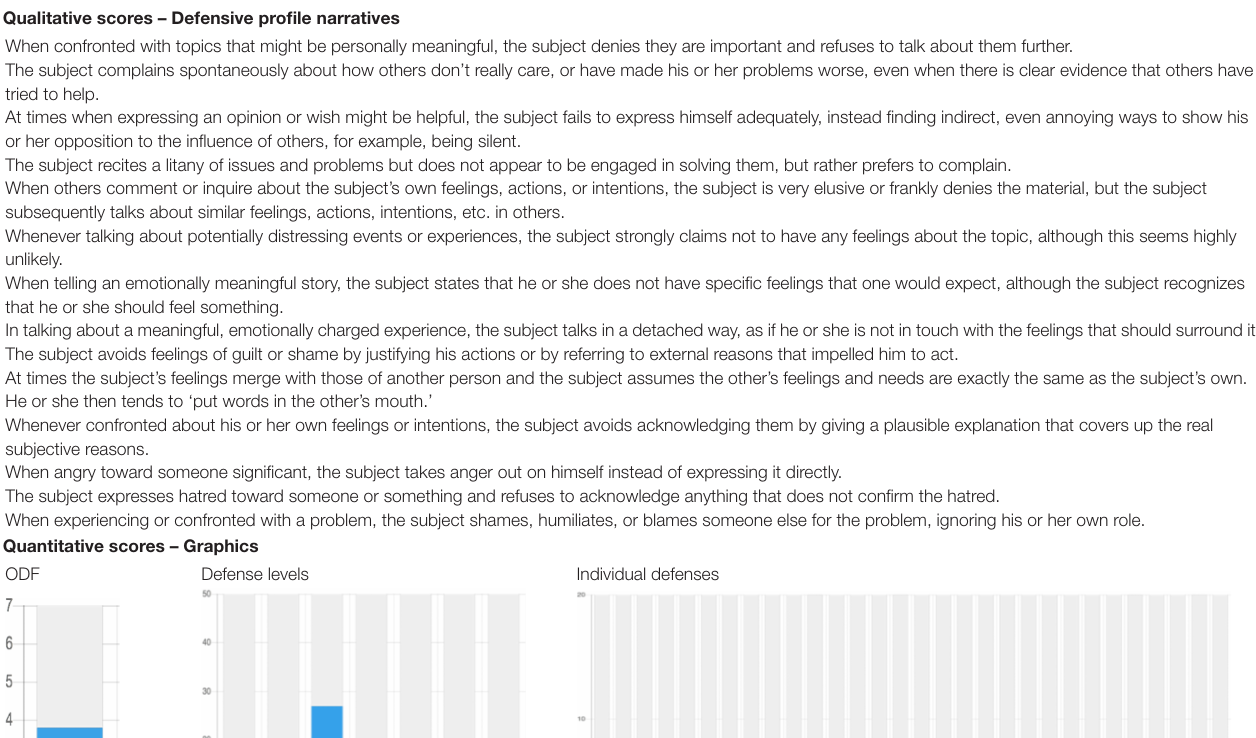
TABLE 10 | Qualitative and quantitative DMRS-Q evaluation of the described in the clinical